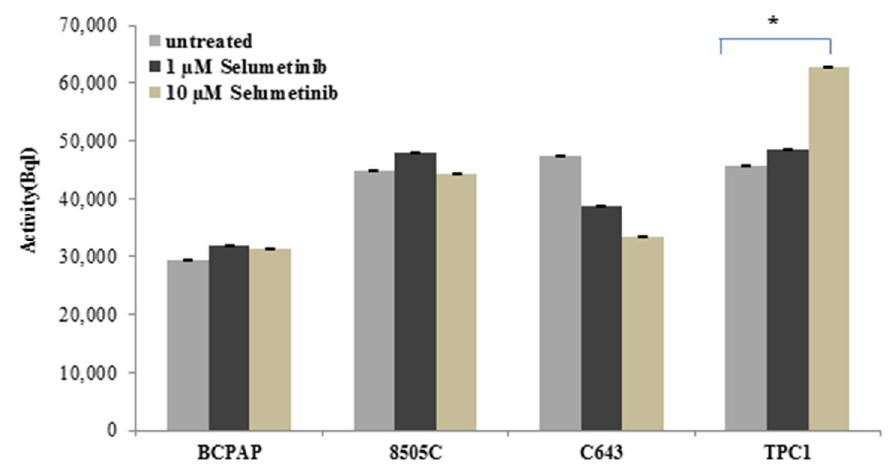
Figure 8. Radioiodine uptake in thyroid carcinoma (TC) cells after treatment with selumetinib. BCPAP, 8505C, C643 and TPC1 cell lines were treated for 48 h with 10 µM selumetinib and 1 MBql I-13. The radioactivity of cells was measured on a gamma counter. Data represent mean ± SEM of experiments performed in triplicates. * p < 0.05 regarded as significant.